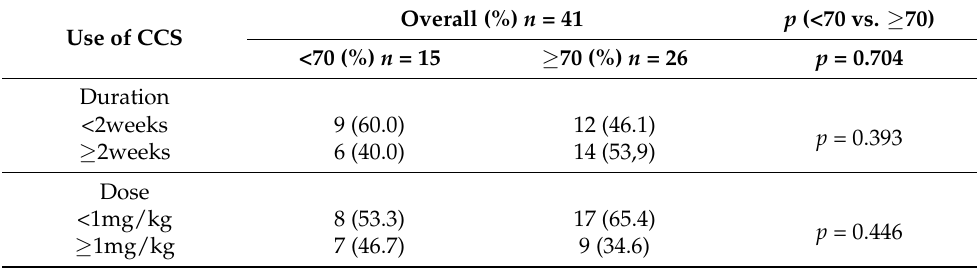
Table 4. Corticosteroids and irAEs. CCS = corticosteroids.